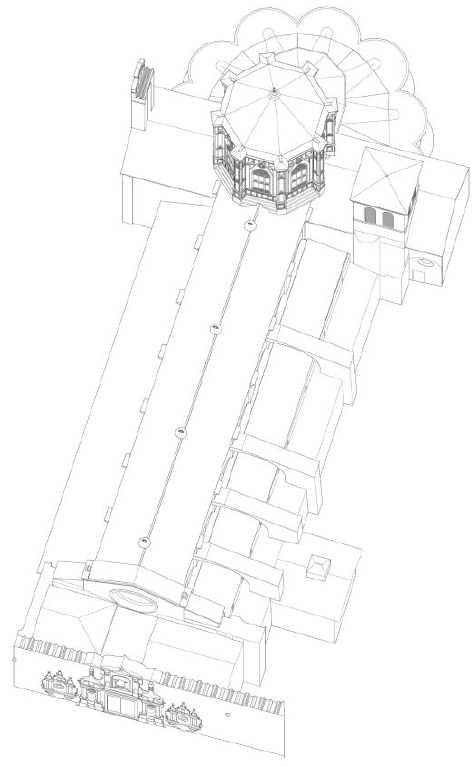
Figure 10. Axonometric aerial view of the Church.